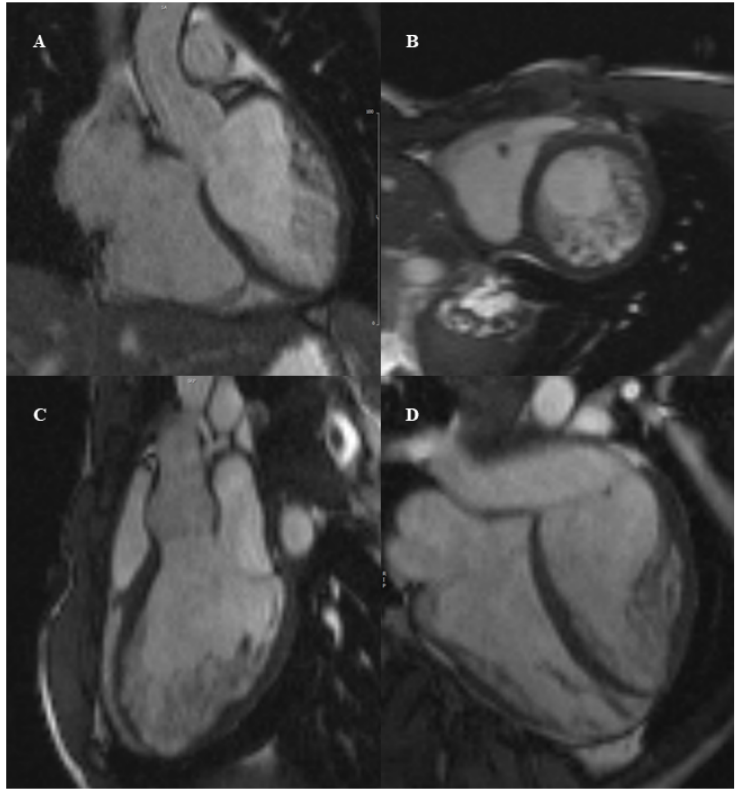
Figure 3. Twelve year-old child, male. Cine sequences were performed in the long-axis (panel A , C , D ) and short-axis view (panel B ) to assess for left ventricular non compaction. The measured non-compacted/compacted ratio was 3.4–4.7 with prevalent hypertrabeculations at the lateral wall, while the septum appears spared. Overall left ventricular function was only mild decreased (ejection fraction 47%).